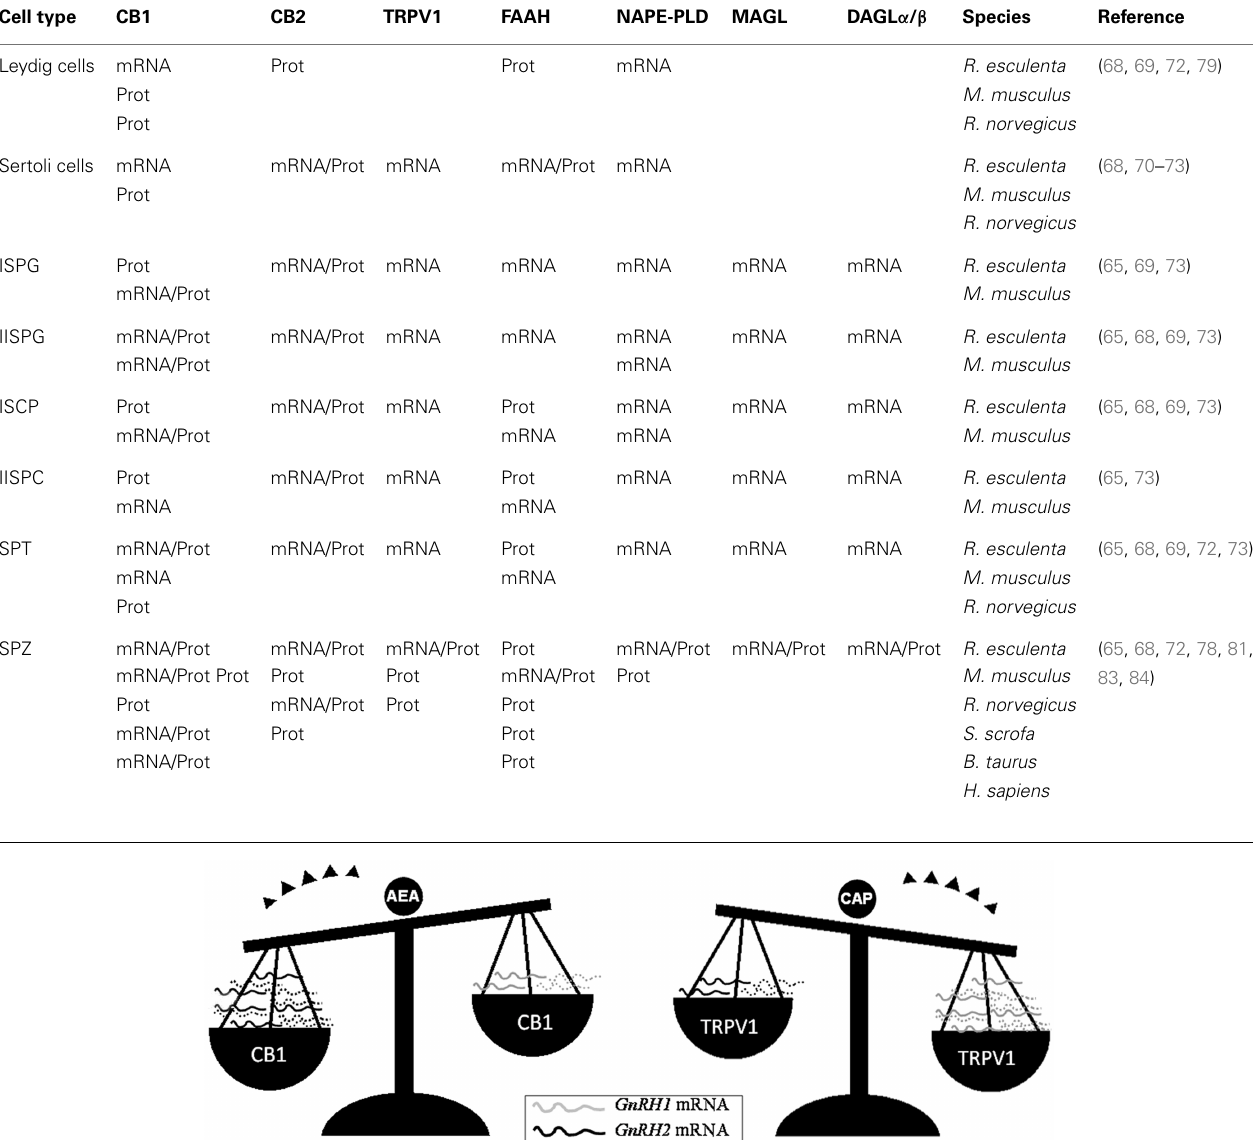
Table 1 | Localization of ECS components [both mRNA and protein (Prot)] in testicular somatic and germ cells .